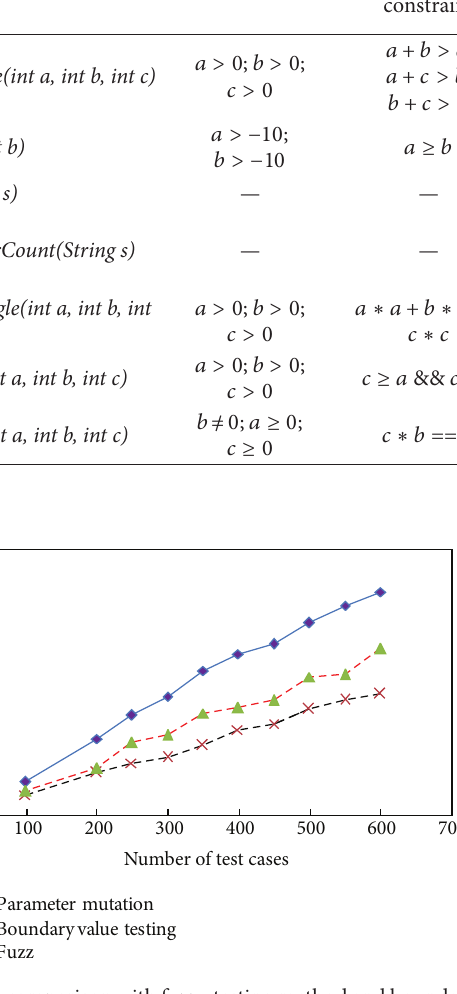
Figure 3: The comparison with fuzzy testing method and boundary value